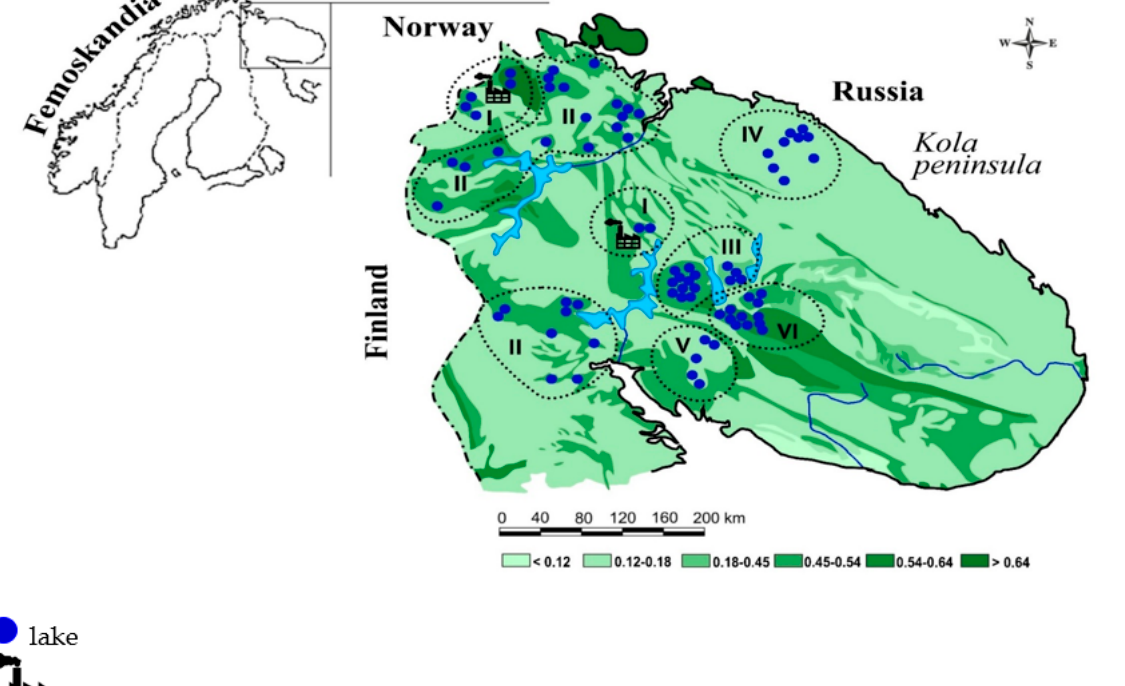
Figure 1. Distribution of rocks with different sensitivity to acidification of the Kola North and lakes with tendencies of water chemistry change. The coefficient (K rock ) is determined as the ratio of major cation oxides to silicon dioxide. Light colors characterize high resistance to chemical weathering and а cid-sensitive catchments; I – VI – subregions.